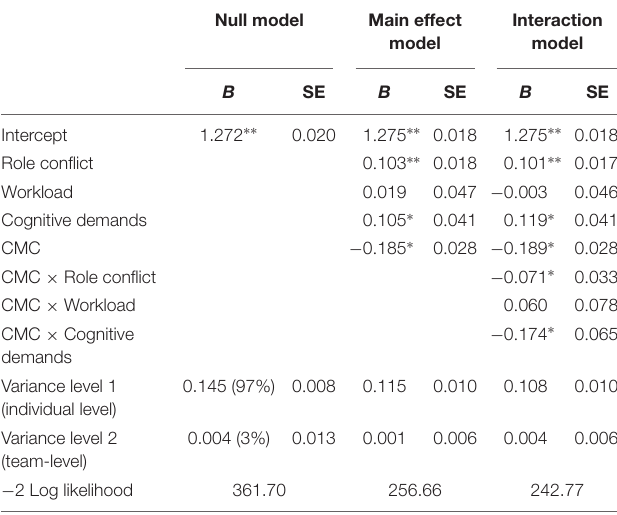
TABLE 2 | Multilevel estimates for the prediction of bullying